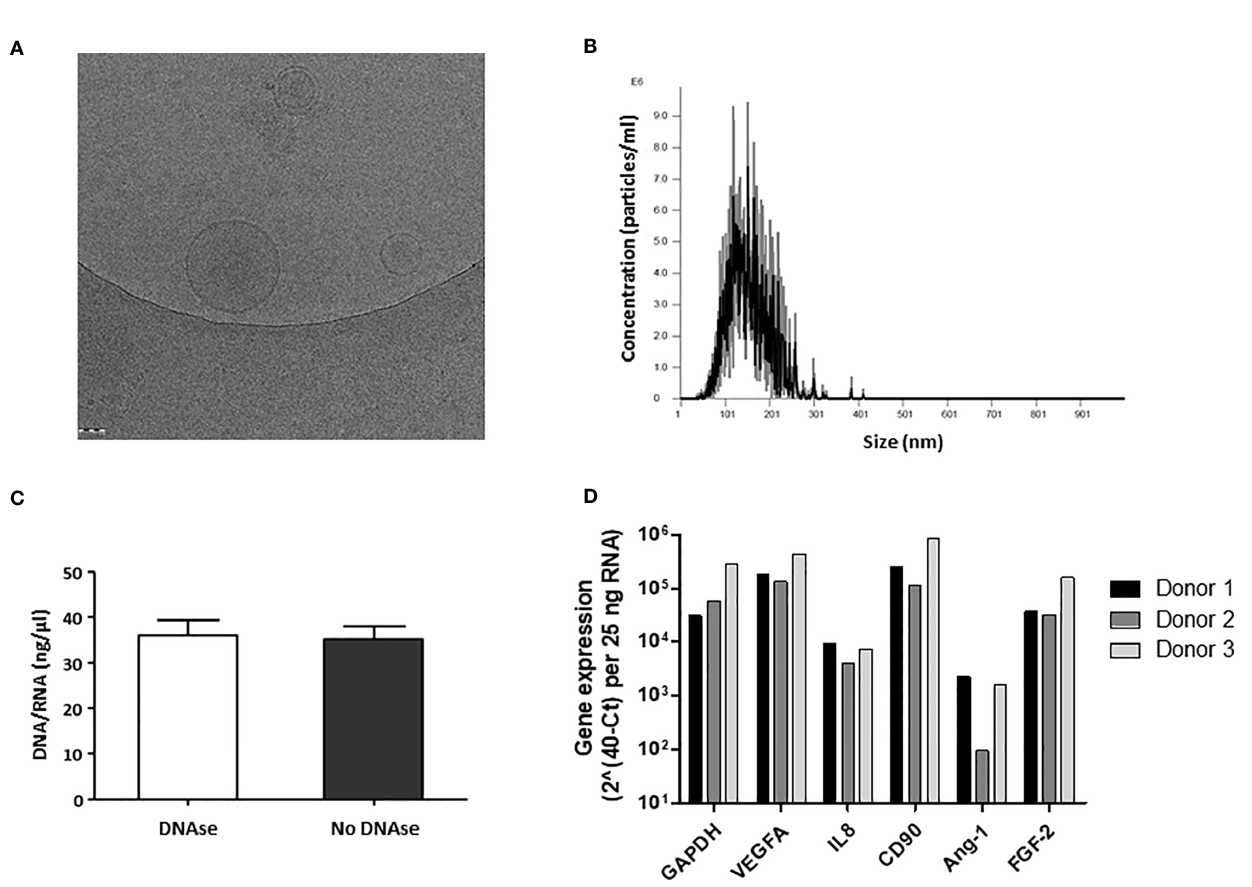
FIGURE 2 | Characterization of physical properties and DNA/RNA composition of membrane particles from MSC. (A) Cryo-electron microscopy images of MP. MP show a spherical shape and a discernible lipid bilayer. (B) A representative pro fi le of the nanoparticle tracking analysis (NTA) of MP. A graph was generated which plots the distribution in size of the MP against the concentration of MP per ml. (C) RNA/DNA concentration (ng/µl) in MP samples before and after DNAse treatment. The error bars represent standard deviation of the mean (SD). (D) Relative gene expression of RNA present in MP samples from three different MSC